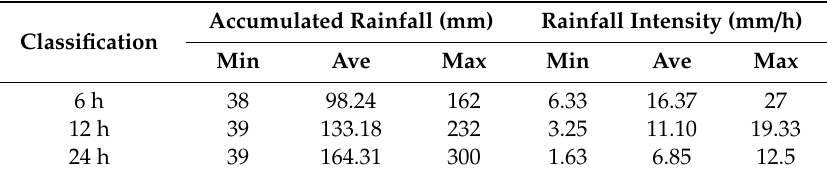
Figure 7. Box plot of rainfall intensity used in this study. Table 3. Analysis of accumulated rainfall and rainfall intensity.